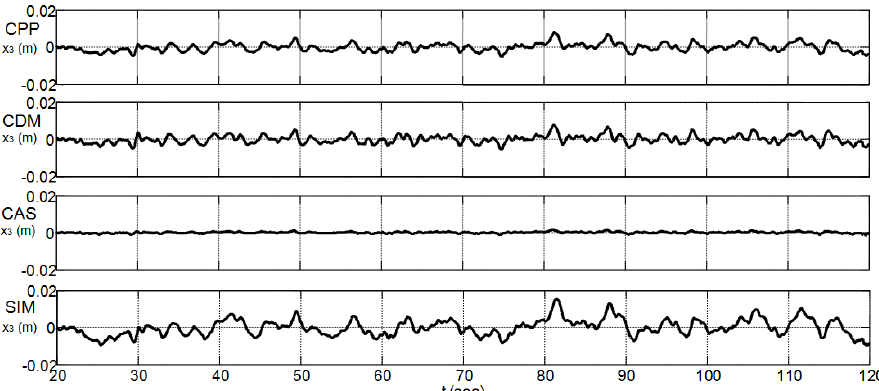
Figure 16. Cart position responses with a disturbance input.